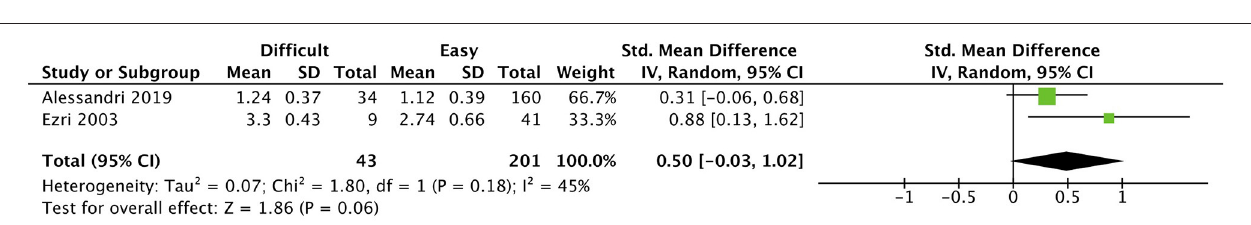
FIGURE 6 | Skin to anterior aspect of the trachea distance at the level of thyroid isthmus forest plot comparing difficult and easy laryngoscopy groups.